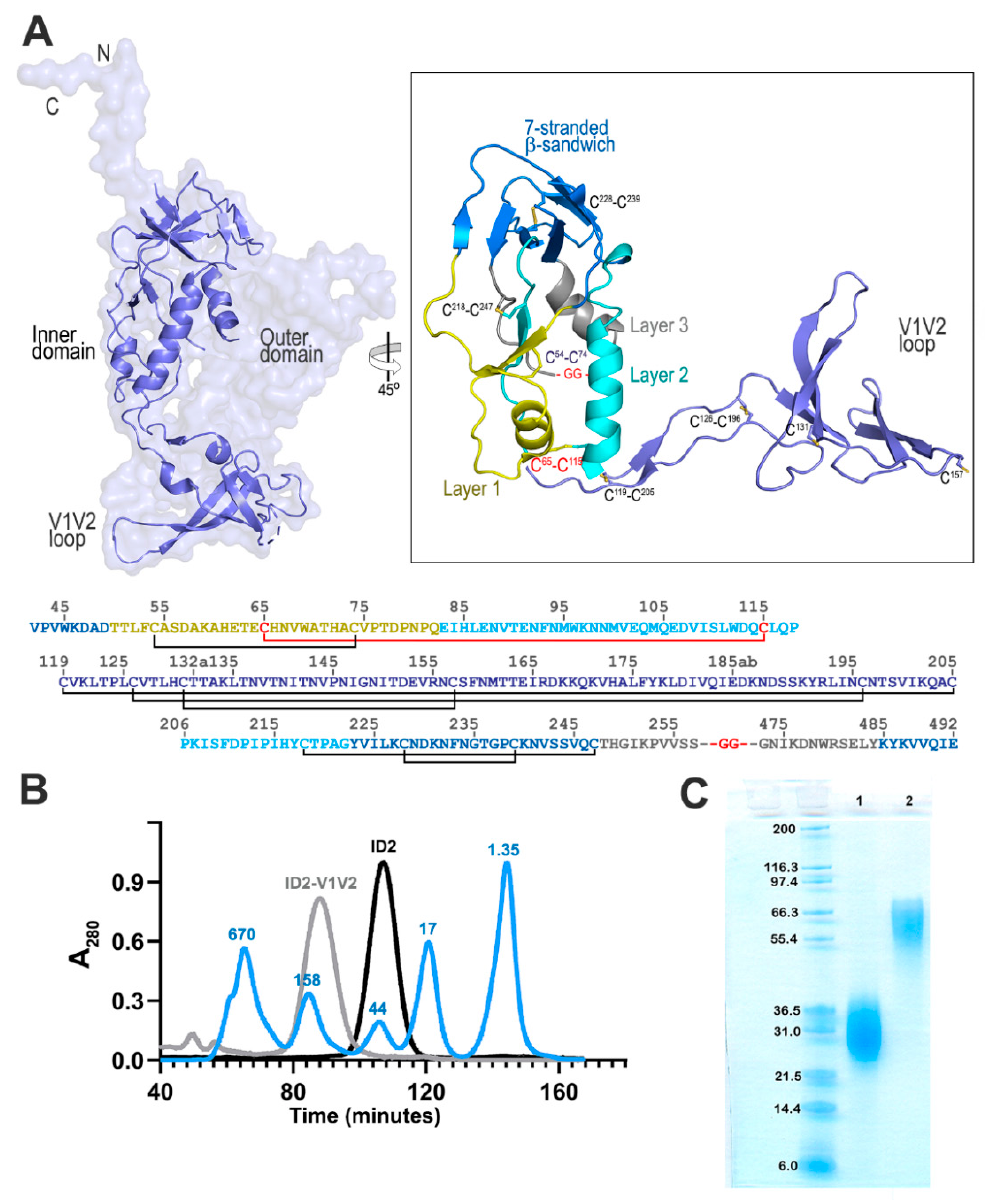
Figure 1. ID2-V1V2 immunogen design and its putative structure. ( A ) Ribbon diagram of the gp120 inner domain and V1V2 loop as is present in the SOSIP trimer with gp120 shown as a surface (left). Putative structure of ID2-V1V2 generated from the structure of ID2 (PDB ID 4YC2) and the V1V2 loop from a CD4 and 17b bound gp120 model (PDB ID 3J70) (right). The “Layered” architecture of the gp120 inner domain is shown with the 7-stranded β -sandwich colored blue, layer 1 yellow, layer 2 cyan, layer 3 gray and the V1V2 loop blue-violet. The ID2-V1V2 sequence is shown below with predicted disulfide bonds present in SOSIP gp120 (black) and ID2 (red). In ID2-V1V2, the gp120 outer domain is replaced by a Gly-Gly linker shown in red. ( B ) Overlay of the gel filtration chromatographs of ID2-V1V2, ID2, and the protein standards, labeled in kDa. ( C ) SDS-PAGE of ID2 (lane 1) and ID2-V1V2 (lane 2) with the protein standards, labeled in